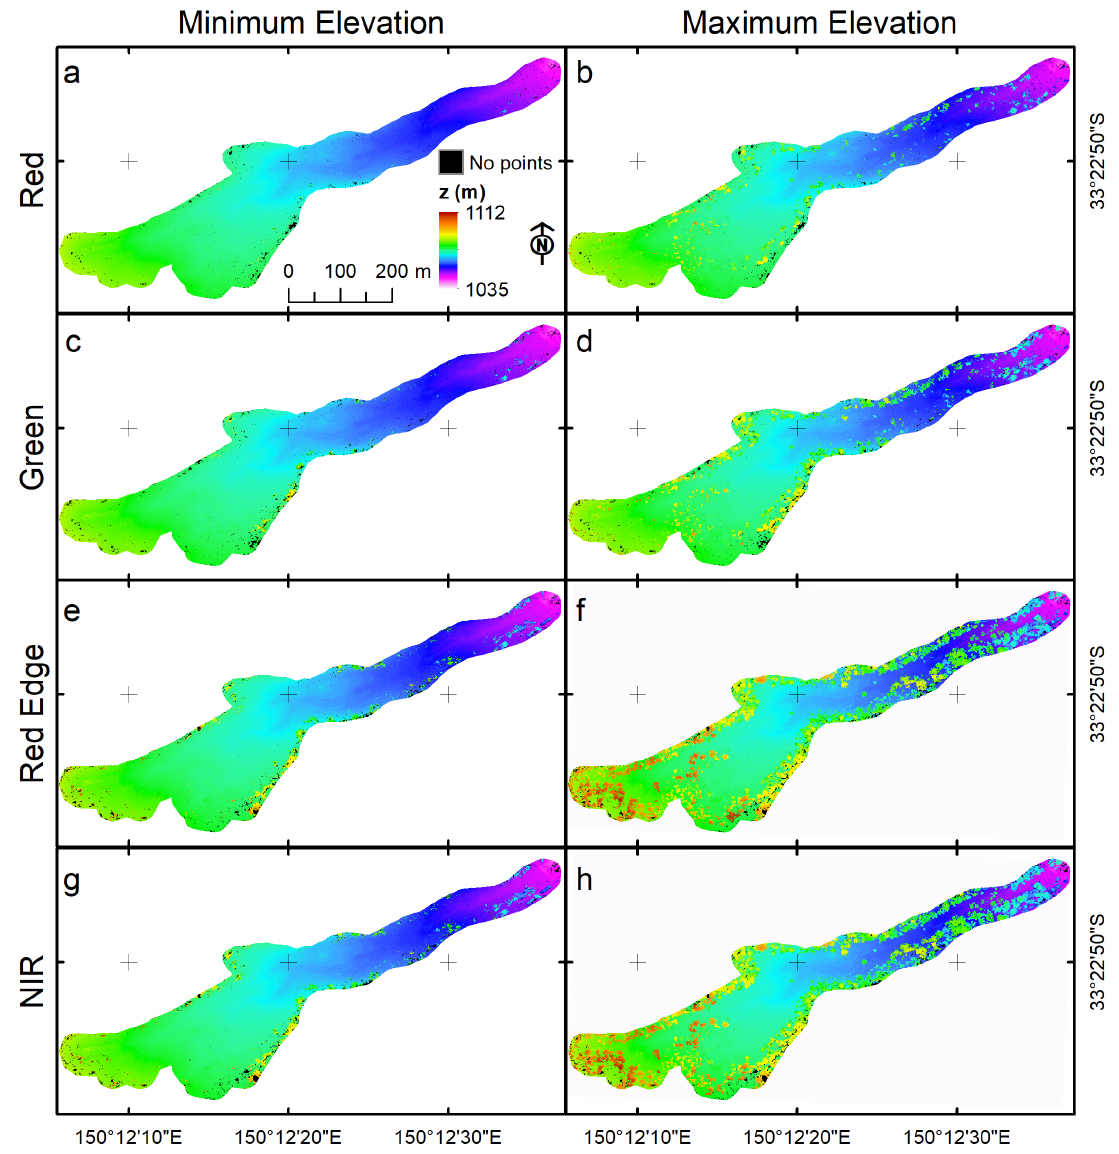
Figure 7. Midday summer multispectral imagery processed to dense point cloud stage as individual cameras and sampled at 2 × 2 pixel resolution (0.16 m GSD) for minimum ( a , c , e , g ) and maximum ( b , d , f , h ) dense point